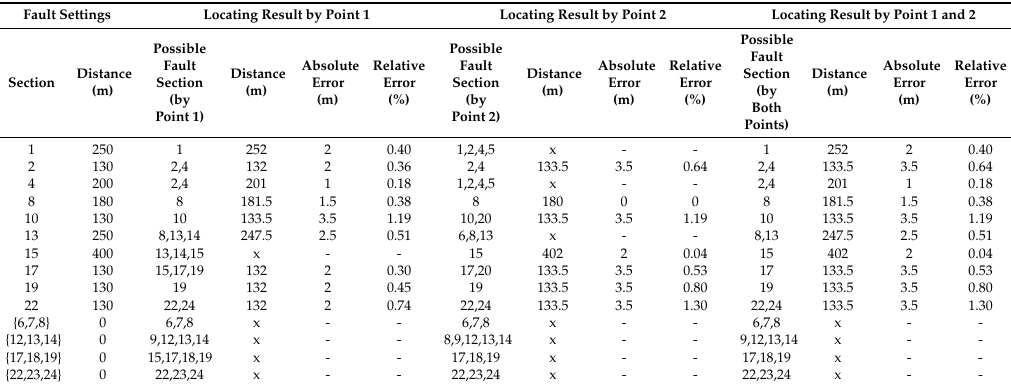
Table 6. Simulation results of the di ff erent fault locations.